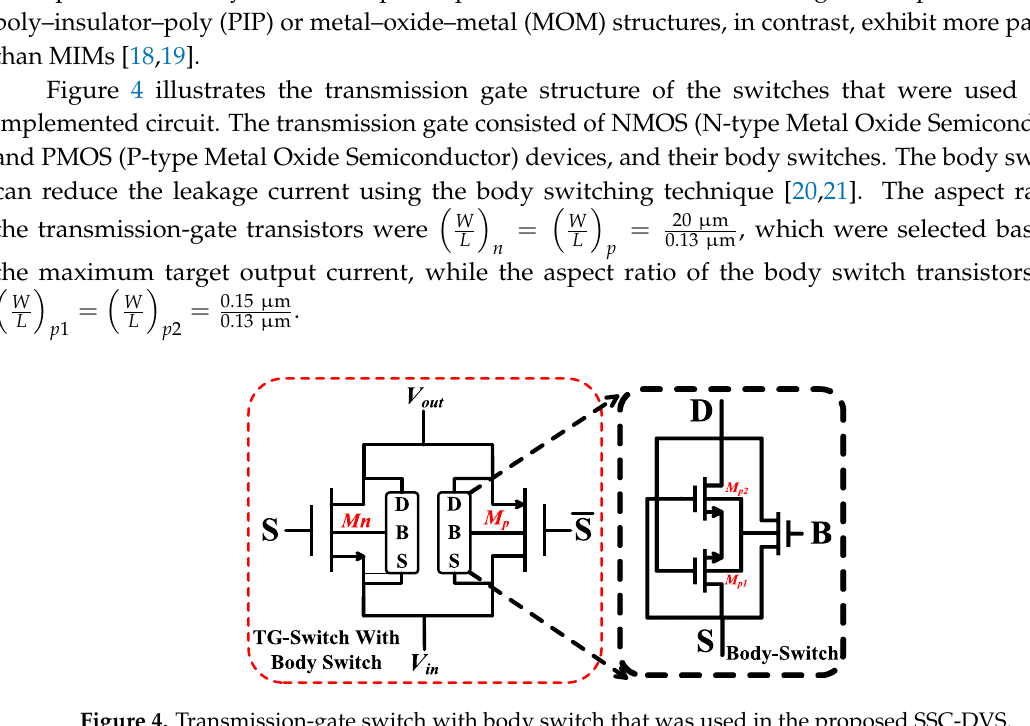
Figure 3. The schematic diagram for the proposed n -bit SSC-DVS architecture. Figure 2. Block diagram of the proposed n -bit SSC-DVS (Dynamic Voltage Scaler) architecture.